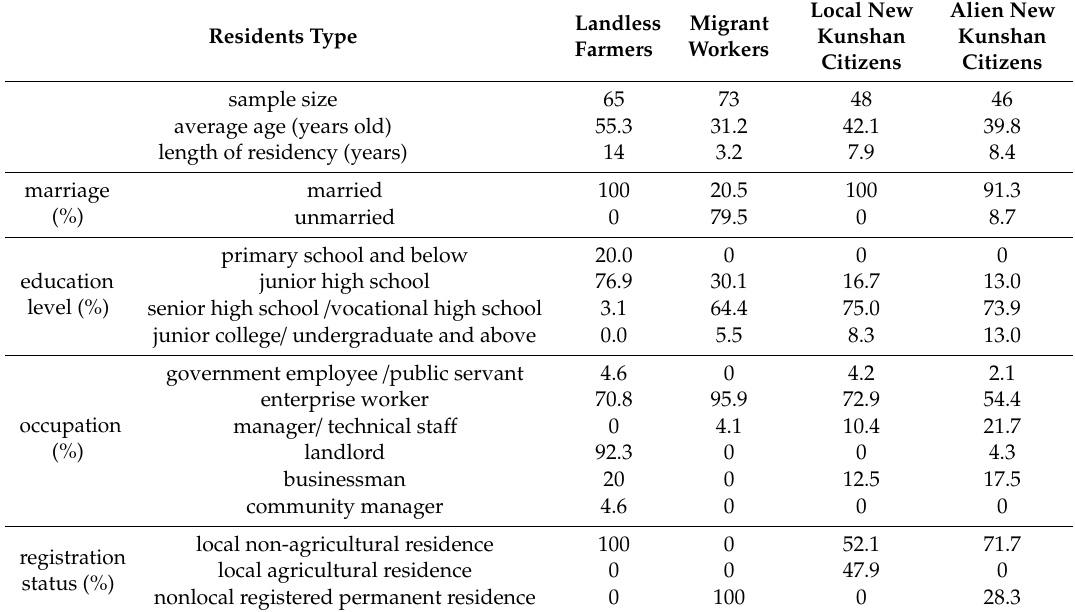
Table 1. Individual attributes of the surveyed